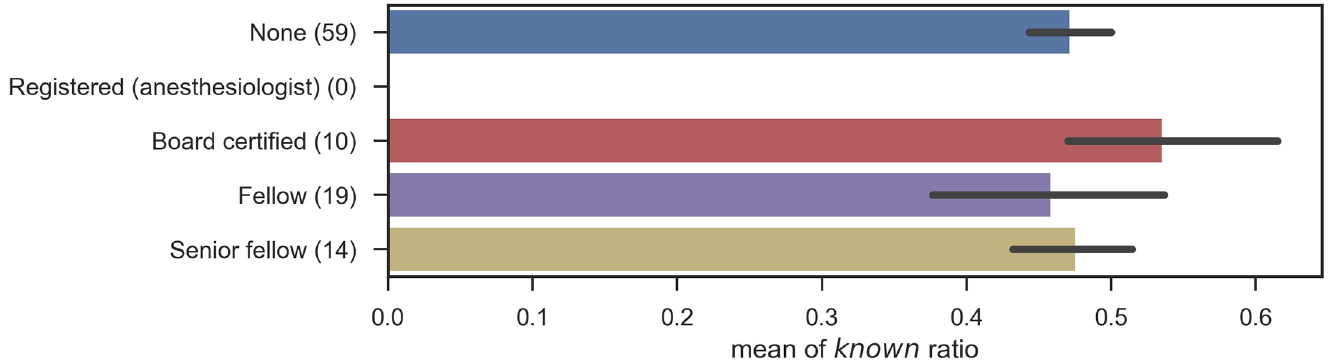
Fig 7. Known ratio, grouped by certification: The error bars shows the standard errors.